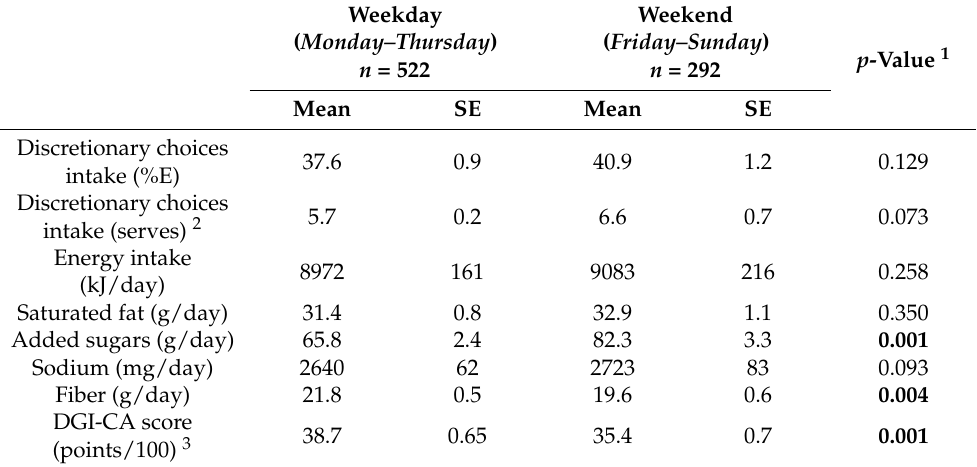
Table 4. Dietary intake of Australian secondary school children (12–17 yo) on weekdays (Monday– Thursday) versus weekend days